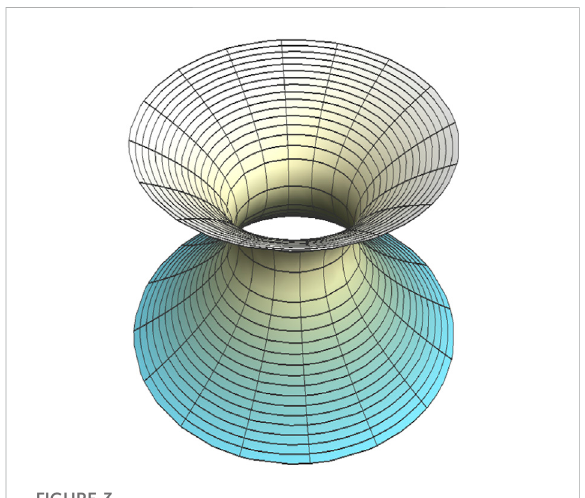
FIGURE 3 Surface revolution of embedding diagram for model I.